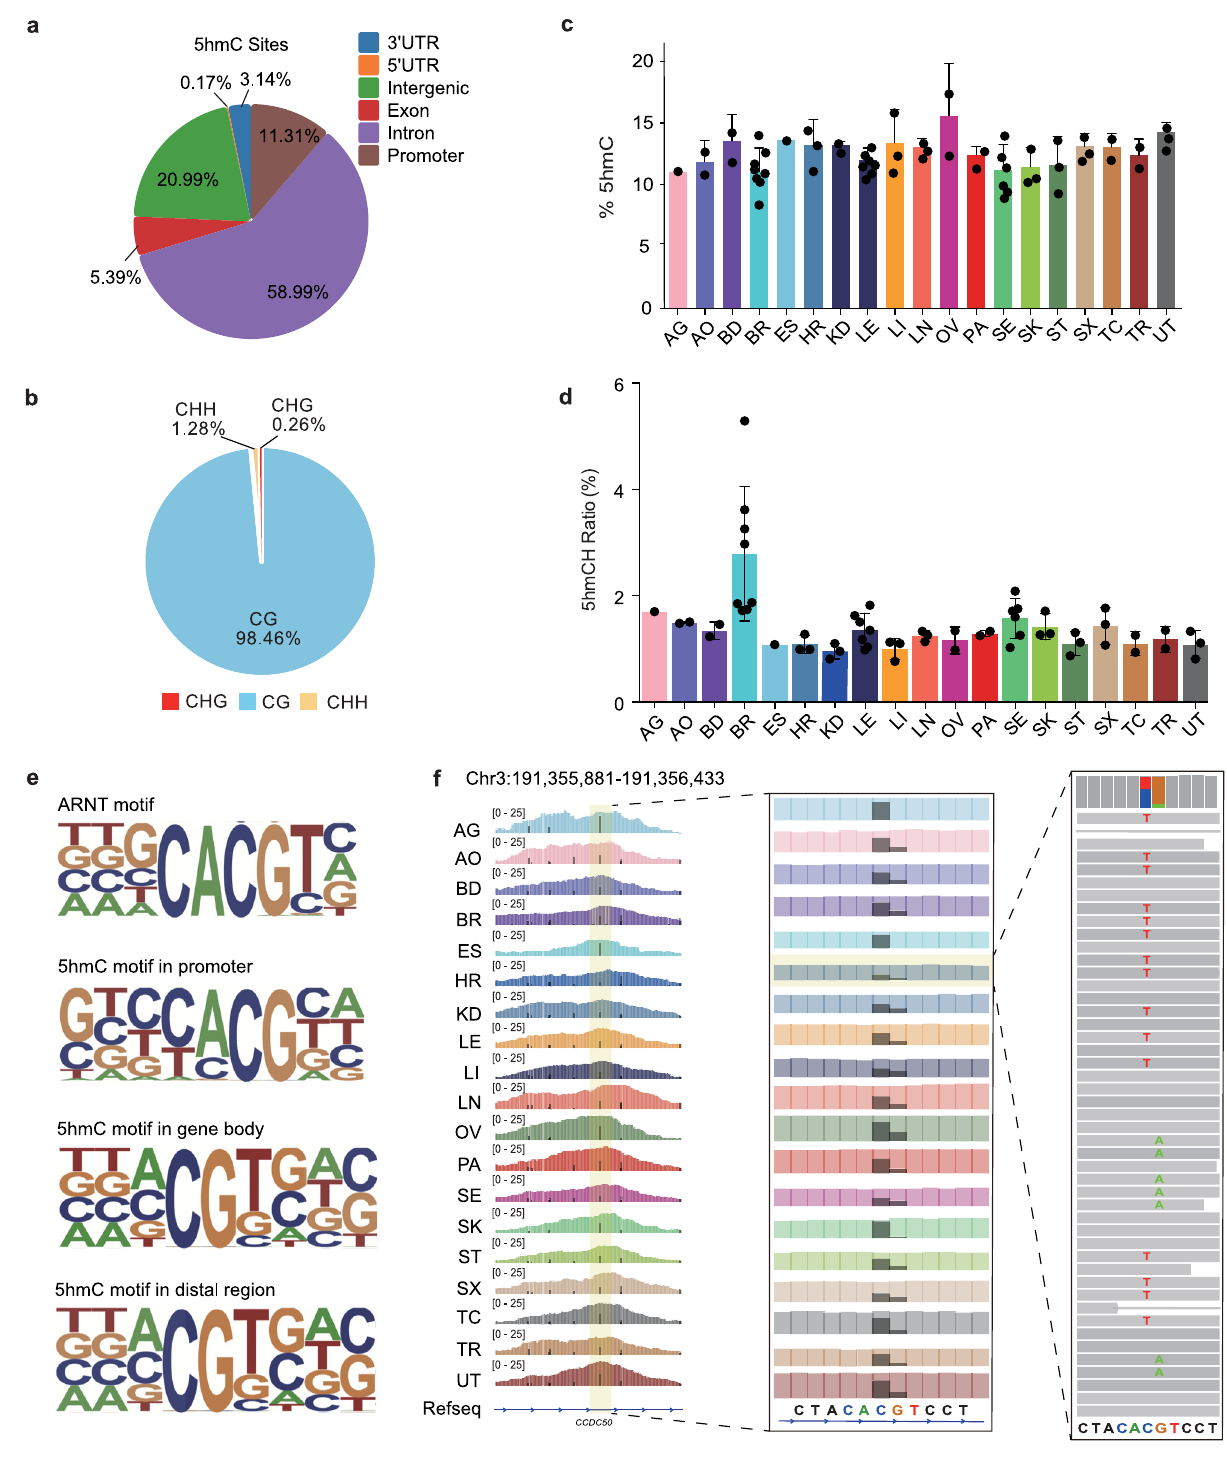
Fig. 2 Single-base-resolution pro fi les of 5hmC. a Pie chart showing the percentage of 5hmC sites in each class of genomic features. b Distribution of 5hmCG, 5hmCHH and 5hmCHG sites. c Average proportion of symmetrically distributed 5hmC sites (Data are represented as mean values + / − SD). The number of samples are shown in Supplementary Table 2. d Proportions of 5hmCH in different tissues (Data are represented as mean values + / − SD). The number of samples are shown in Supplementary Table 2. e The most signi fi cant 5hmC motif in different genomic elements demonstrates partial sequence overlap with the known transcription factor motif of ARNT. f IGV visualization of the 5hmC site signals on chromosome 3. The gray bar represents the C- to-T counts. 5hmC is asymmetrical at the 5hmCG